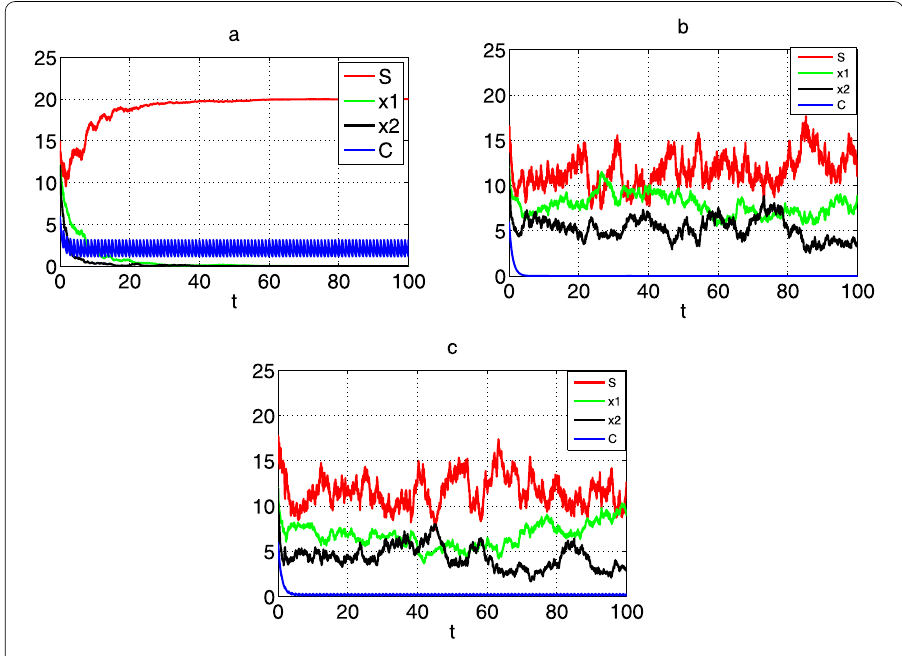
Figure 2 Computer simulation of the paths S ( t ), x 1 ( t ), x 2 ( t ), c ( t ) of the stochastic chemostat model (2) for impulsive effects. (a) Time series for S ( t ), X 1 ( t ), X 2 ( t ), c ( t ) with parameters σ 1 = 0.1, σ 2 = 0.1, u = 2. (b) Time series for S ( t ), X 1 ( t ), X 2 ( t ), c ( t ) with parameters σ 1 = 0.1, σ 2 = 0.1, u = 0. (c) Time series for S ( t ), X 1 ( t ), X 2 ( t ), c ( t ) with parameters σ 1 = 0.1, σ 2 = 0.1, u =